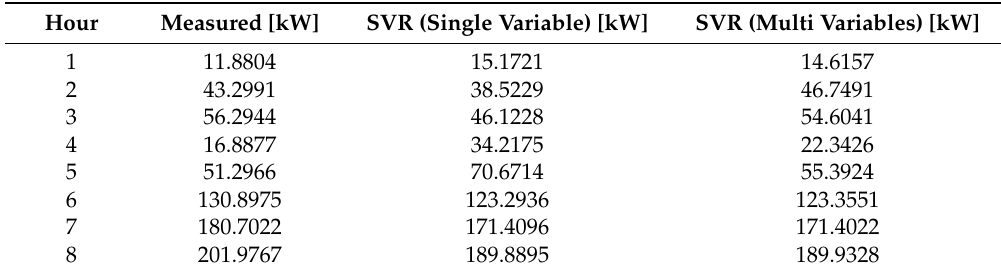
Table A2. Measured and forecasted wind power outputs on 11 January